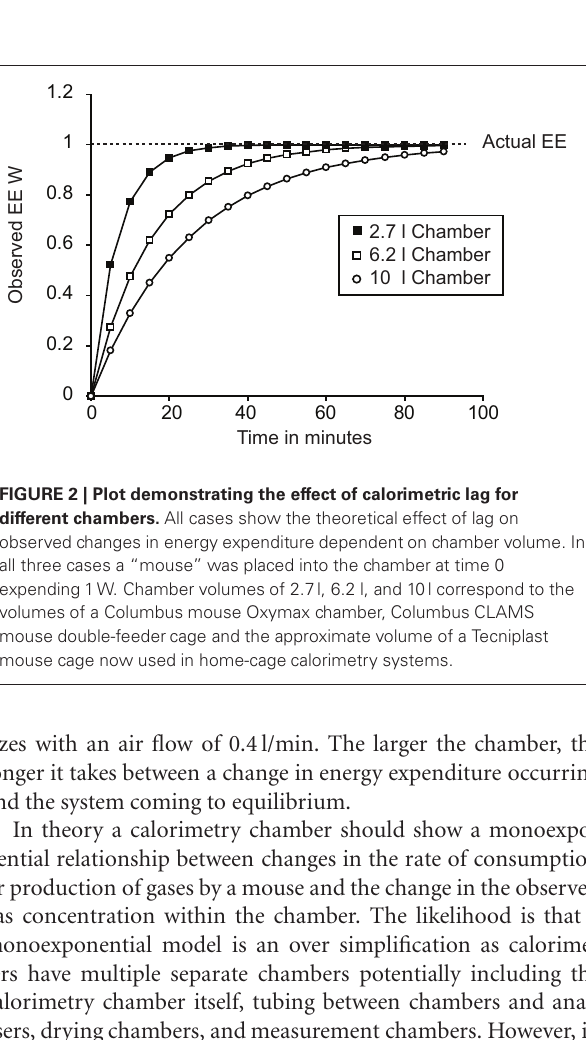
sizes with an air flow of 0.4 l/min. The larger the chamber,